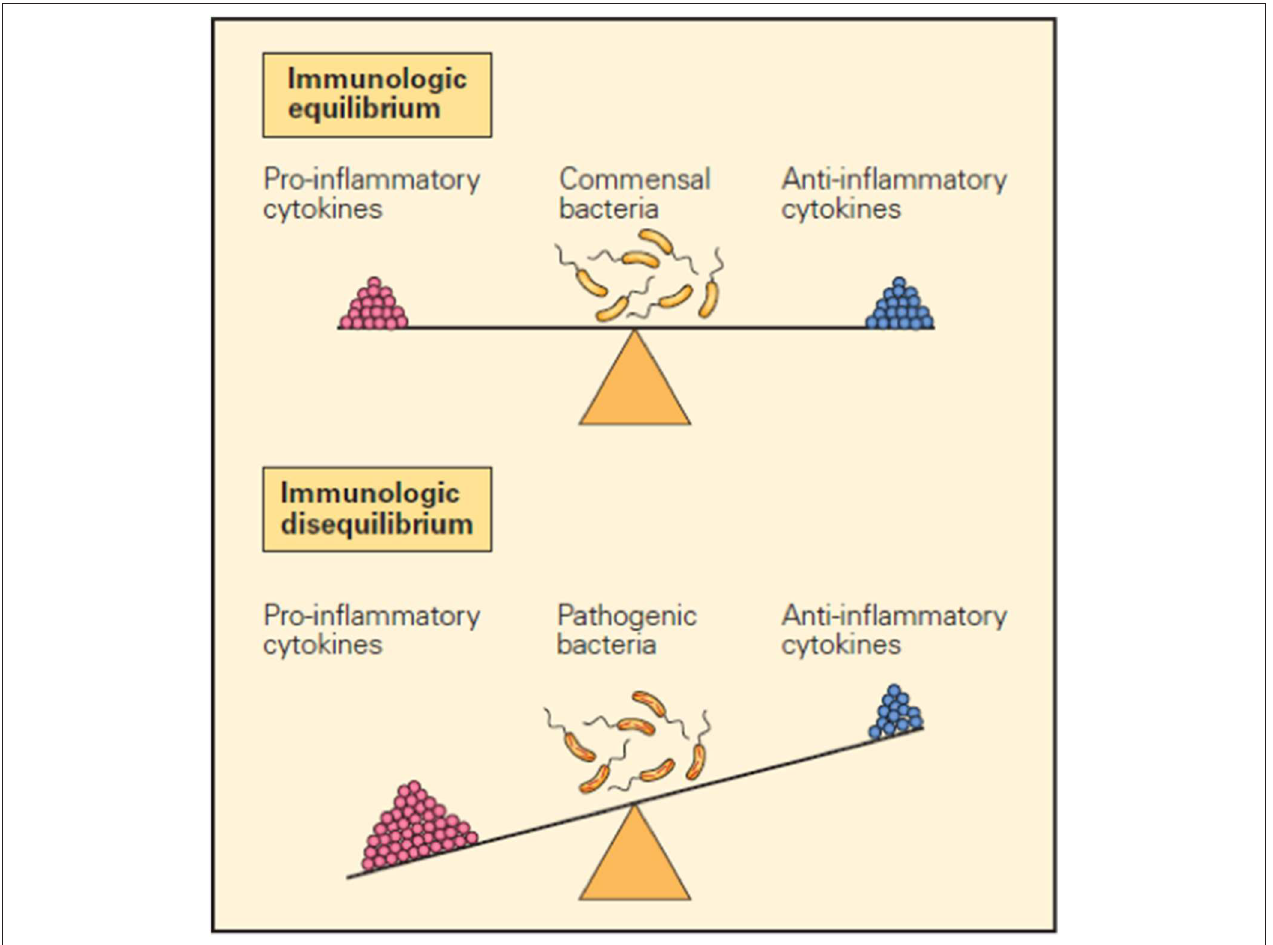
FIGURE 1 | Schematic representation of the opposing pro- and anti-inflammatory functions of cytokines in maintaining immunological equilibrium. A balanced production of pro- and anti-inflammatory cytokines in response to a foreign configuration is one of the mechanisms that contribute to immunological equilibrium (upper panel). Conversely, immunological imbalance or disease is seen when there is overproduction of pro-inflammatory cytokines and/or inadequate production of anti-inflammatory cytokines (lower panel)